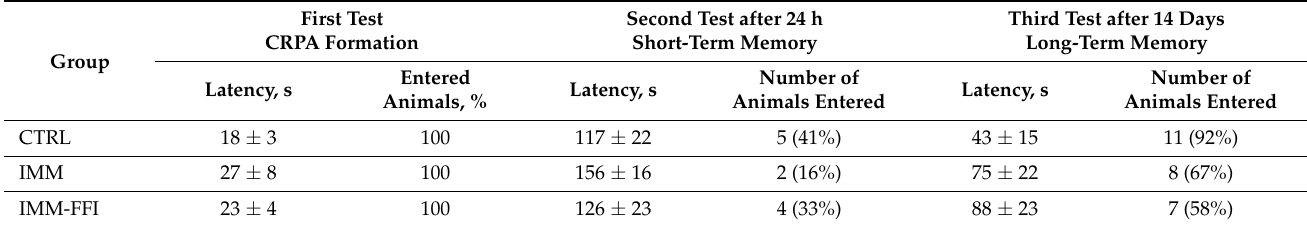
Table 2. Behavioral reactions of rats in the CRPA test.